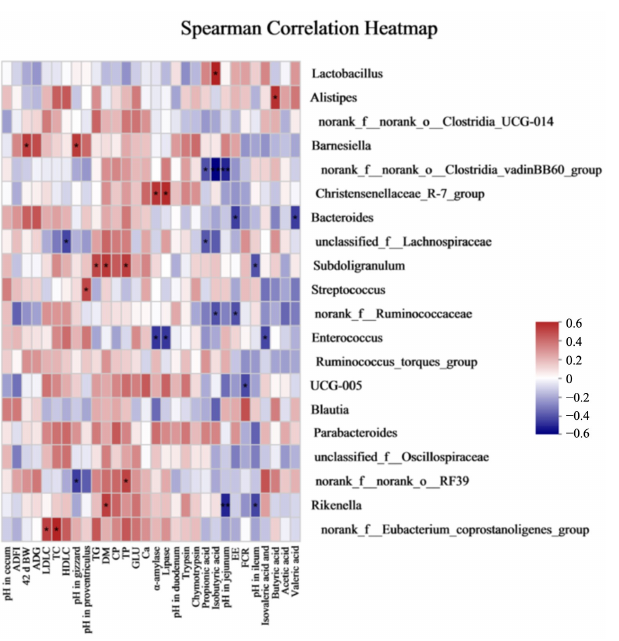
Figure 4. Heatmap of Spearman’s correlation among cecal microbiota and the parameters of growth performance, lipid metabolism profiles, pH value in chyme, enzyme activities, and VFA contents during the grower phase. Red suggests a positive correlation, and green suggests a negative correlation. “*” indicates 0.01 < p ≤ 0.05 and “**” indicates 0.001 < p ≤ 0.01.